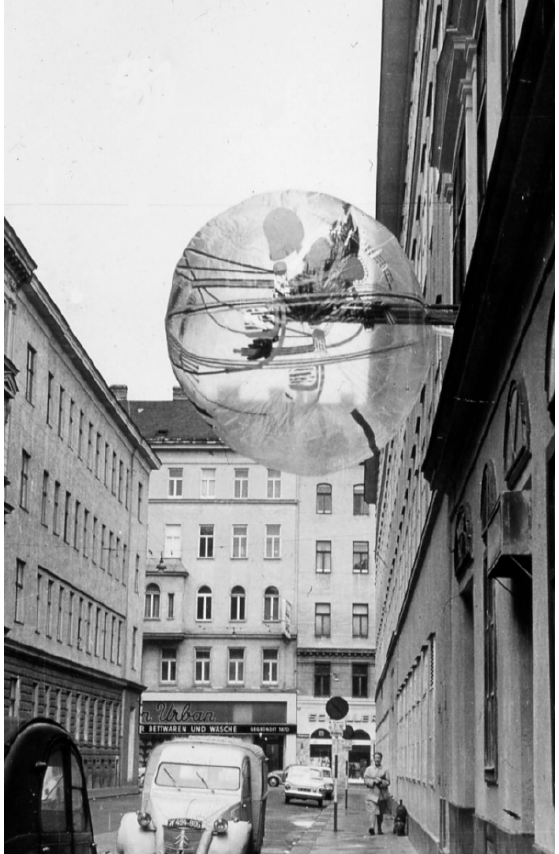
Figure 6. Haus-Rucker-Co, Ballon für Zwei, 1967. Installation view Apollogasse, Vienna. © Haus- Rucker-Co L. u. M. Ortner.